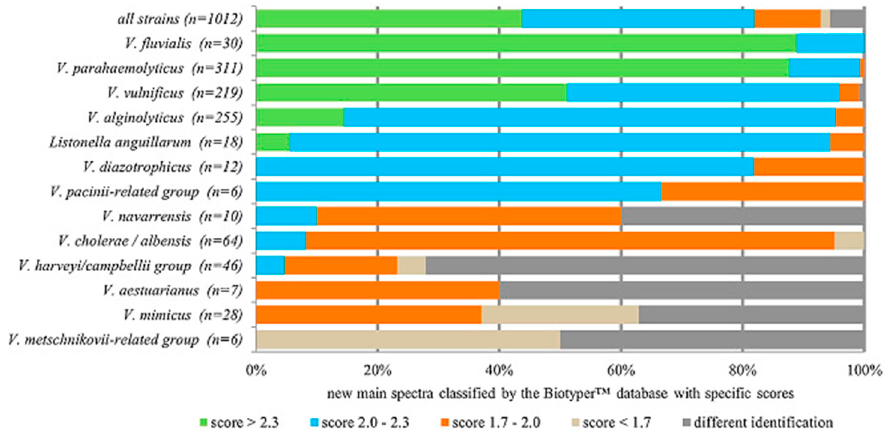
Figure 1. Classification of new main spectra with the Biotyper™ database. The highest matching scores of the new main spectra were divided into ranges reflecting highly probable species identifications (>2.3), probable species identifications (2.0–2.3), secure genus identifications (1.7–2.0), and unreliable identifications (<1.7). Strains with Biotyper™ species classifications are different from the species assignment for VibrioBase main spectra. (Re-printed from Erler et al. [28]. Copyright (2015), with permission from Elsevier).